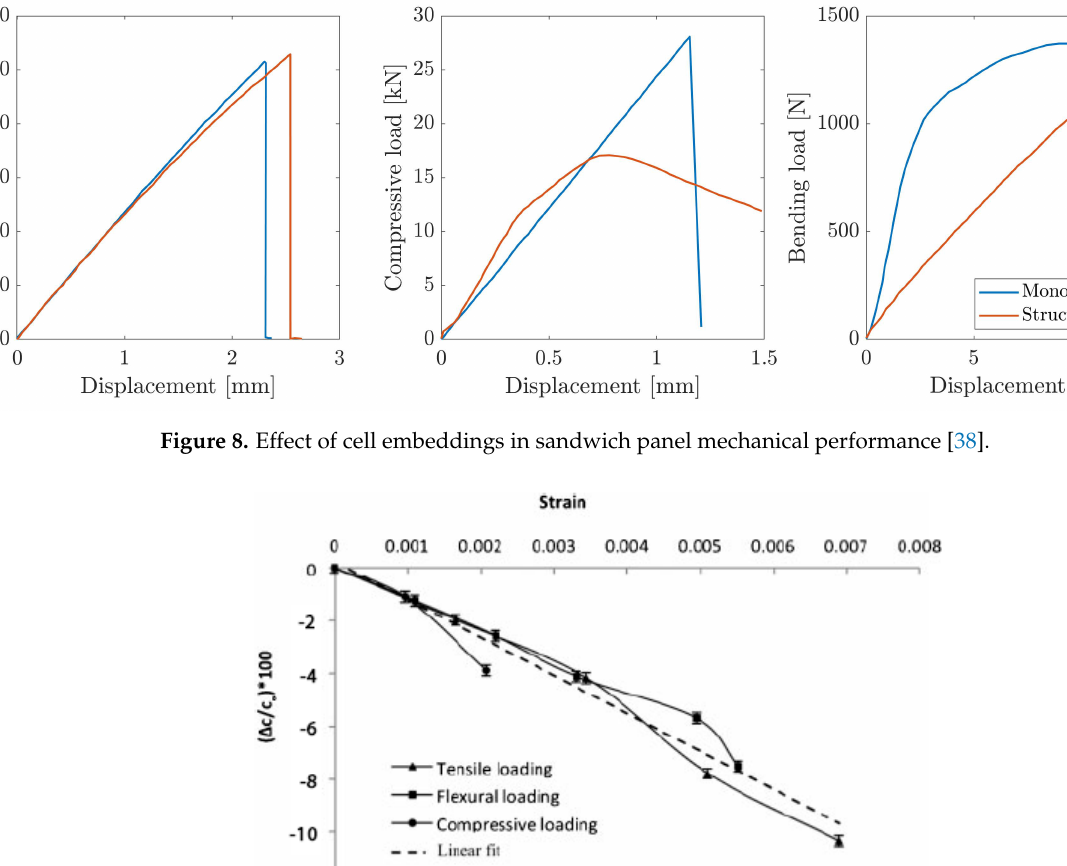
Figure 9. Strain-induced battery capacity loss